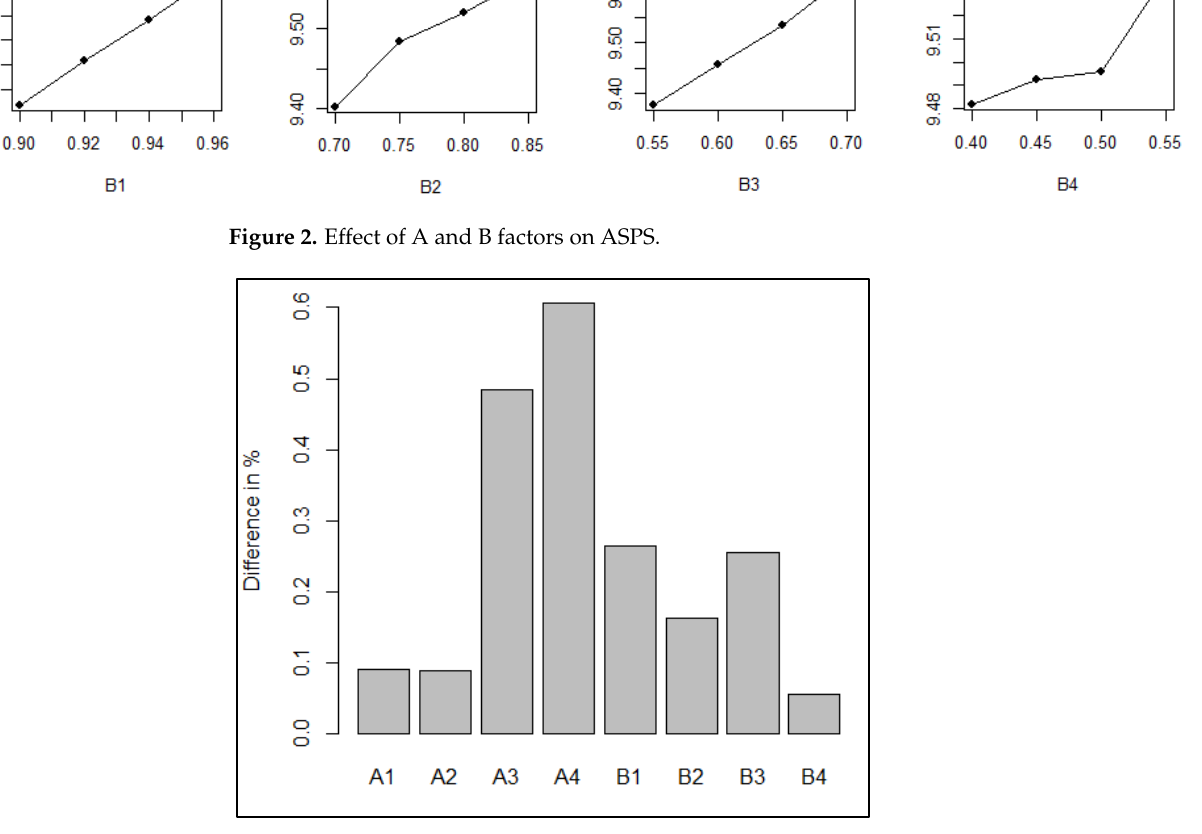
Figure 3. The difference that each factor makes.